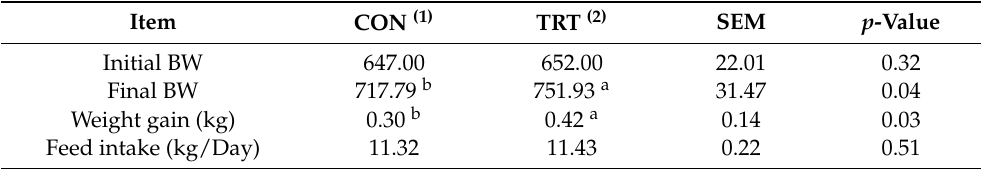
Table 2. Effect of stevioside and organic selenium on growth performances of Hanwoo cattle (experimental period: 243 days).